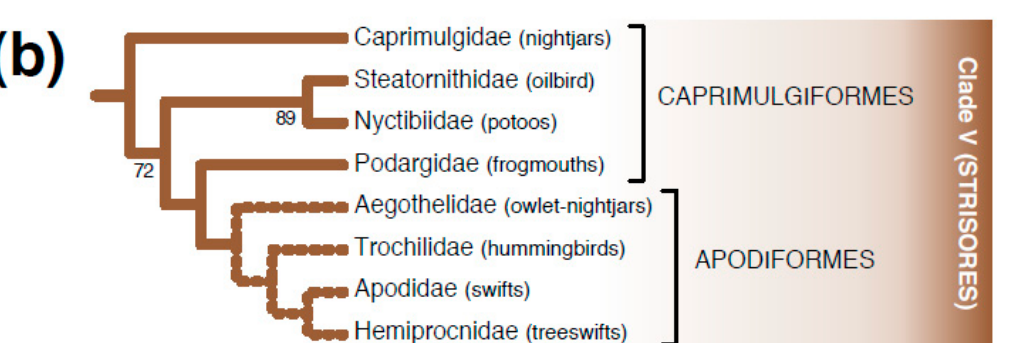
Figure 3. Phylogenomic supertree generated by matrix representation with parsimony (MRP) analysis using all three backbone trees. ( a ) Large-scale structure with support from the MRP bootstrap analysis. All nodes received 100% bootstrap support except as noted. The line for Apodiformes is dashed; we did this to indicate that the ordinal circumscriptions in the IOC World Bird List (v. 7.3) nest Apodiformes within a paraphyletic Caprimulgiformes, assuming the supertree topology is correct. Superordinal groups (the “magnificent seven”) are numbered following Reddy et al. [39]. ( b ) Relationships among families within Apodiformes and Caprimulgiformes, emphasizing paraphyly of the latter. A complete supertree with all species labeled is available in Supplementary Material.